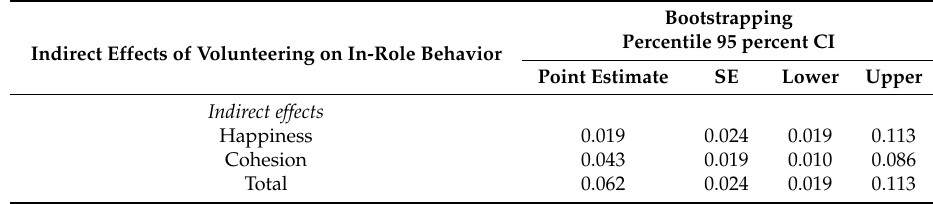
Table 5. Indirect effects of volunteering on in-role behavior.